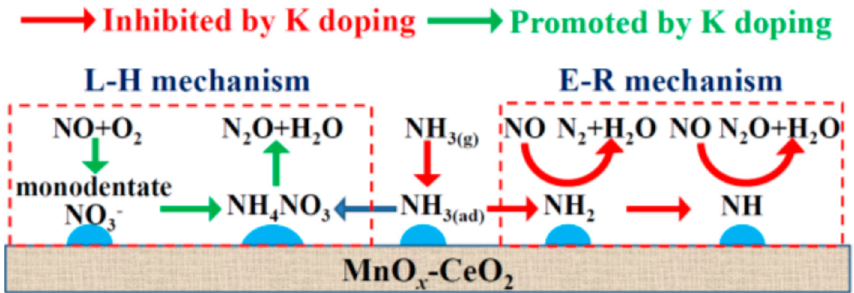
Figure 3. The effect of K doping on the formation of N 2 O by Langmuir-Hinshelwood and Eley-Rideal mechanisms. Reproduced from Reference [45].